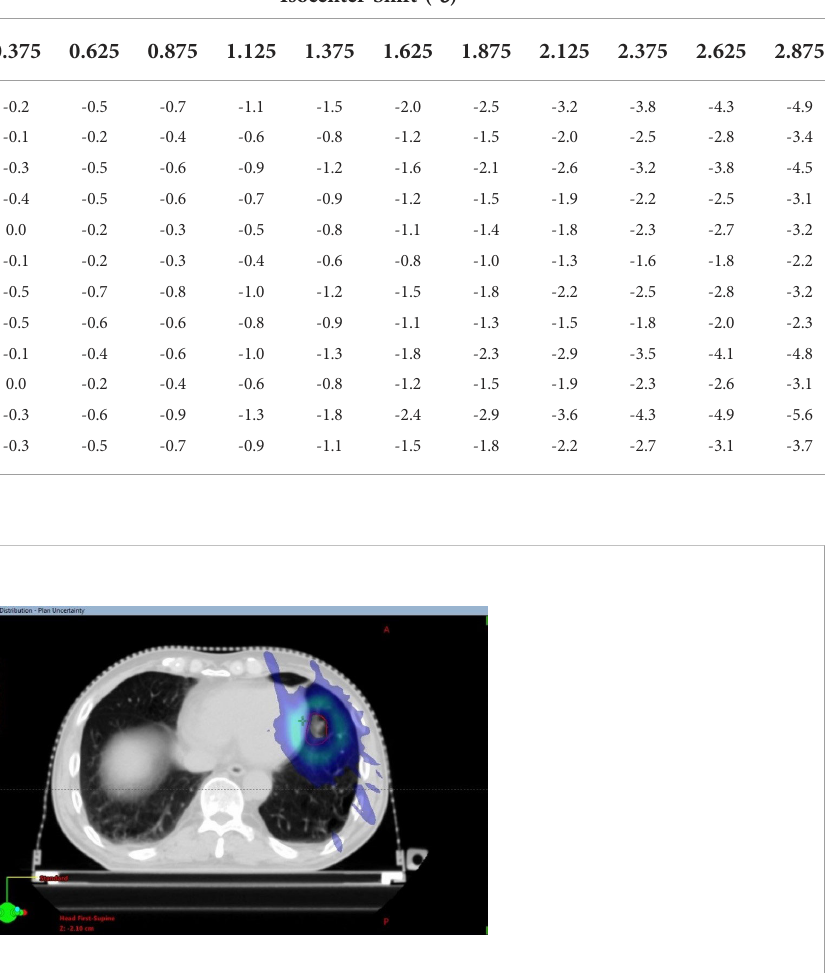
TABLE 3 Dose difference of ITV and GTV variation along with the isocenter shift. Patient No.